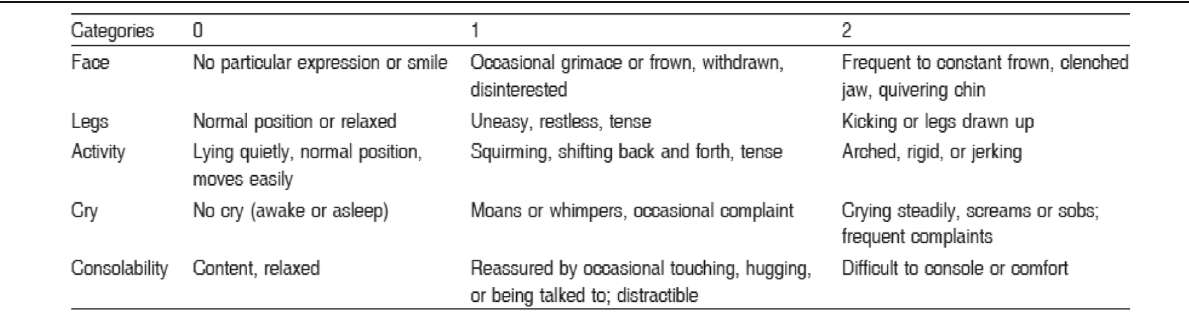
Table 1 FLACC behavioural pain assessment scale score (Merkel et al.,